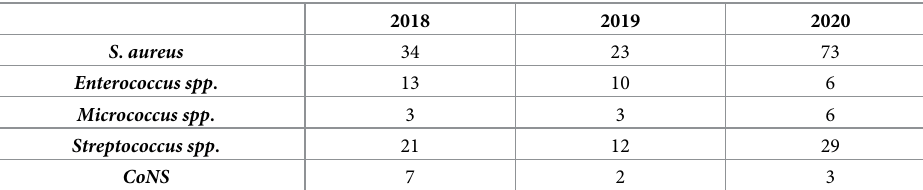
Table 7. The frequency of MDR in